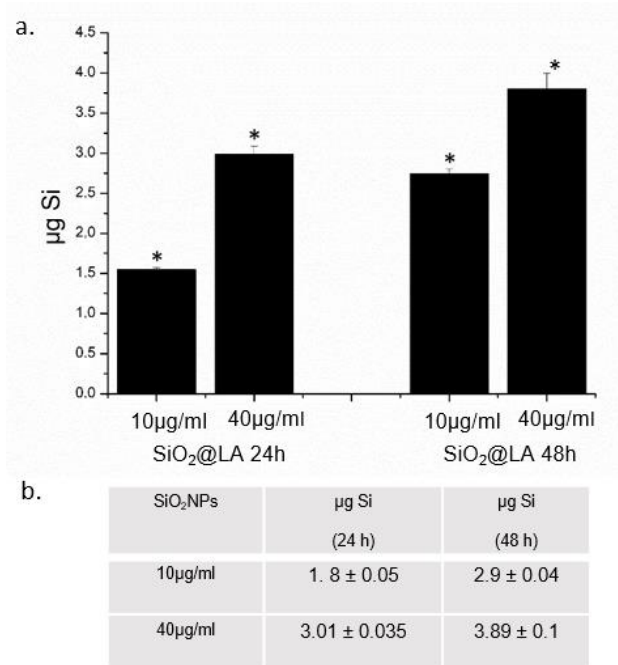
Figure 4. a . SiO 2 @LA NPs accumulation in MCF-7 cell lines exposed to 10 µ g / mL and 40 µ g / mL of NPs for 24 h and 48 h. Cells were then harvested, live cells were counted and Si content was measured in 360,000 cells ( µ g Si). b . blank SiO 2 NPs (10 µ g / mL and 40 µ g / mL) uptake in MCF-7 expressed as µ gSi after 24 h and 48 h Data reported as mean ± SD from three independent experiments; statistical significance of exposed cells vs. control cells for p value ˂ 0.05 (<0.05 *).